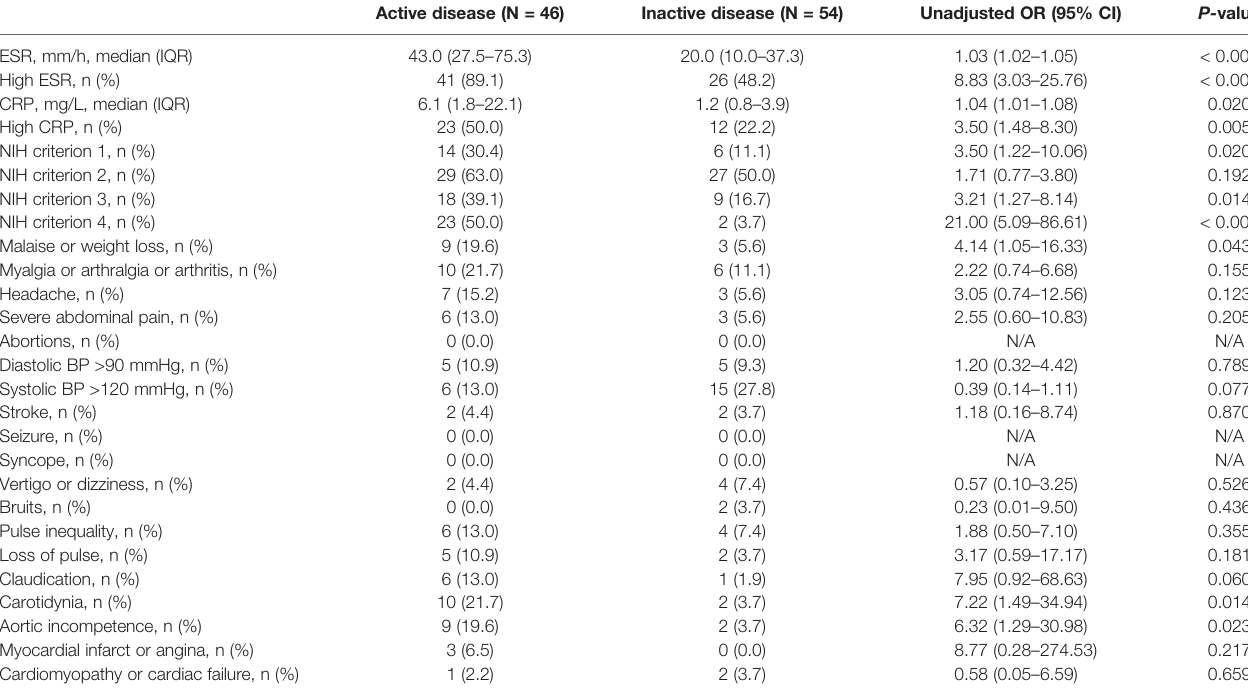
TABLE 2 | Comparison of individual items constituting disease activity assessment tools between active and inactive patients in the derivation cohort according to the PGA. Active disease (N =